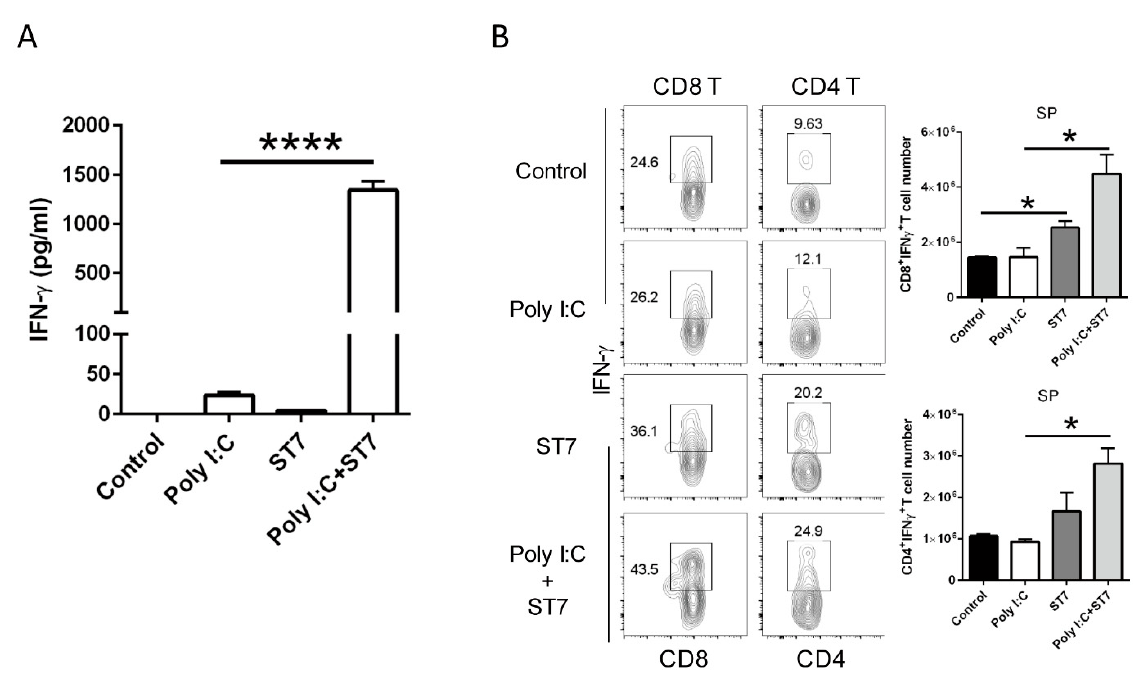
Figure 7. ST7 treatment increases the IFN- γ -induced production of T cells after poly I:C stimulation. ( A ) Splenocytes were incubated with poly I:C, ST7, and poly I:C + ST7 for 24 h. IFN- γ was then quantified in the culture supernatant through an enzyme-linked immunosorbent assay. n = 3, **** p < 0.001. ( B ) The expression of IFN- γ by CD8 + T and CD4 + T cells in the spleen (SP) after 2 h of poly I:C stimulation was analyzed using flow cytometry. The CD8 + IFN- γ + T and CD4 + IFN- γ + T cell counts in the SP are represented as bar graphs. Data are represented as mean ± SEM. n = 5 per group, * p < 0.05.